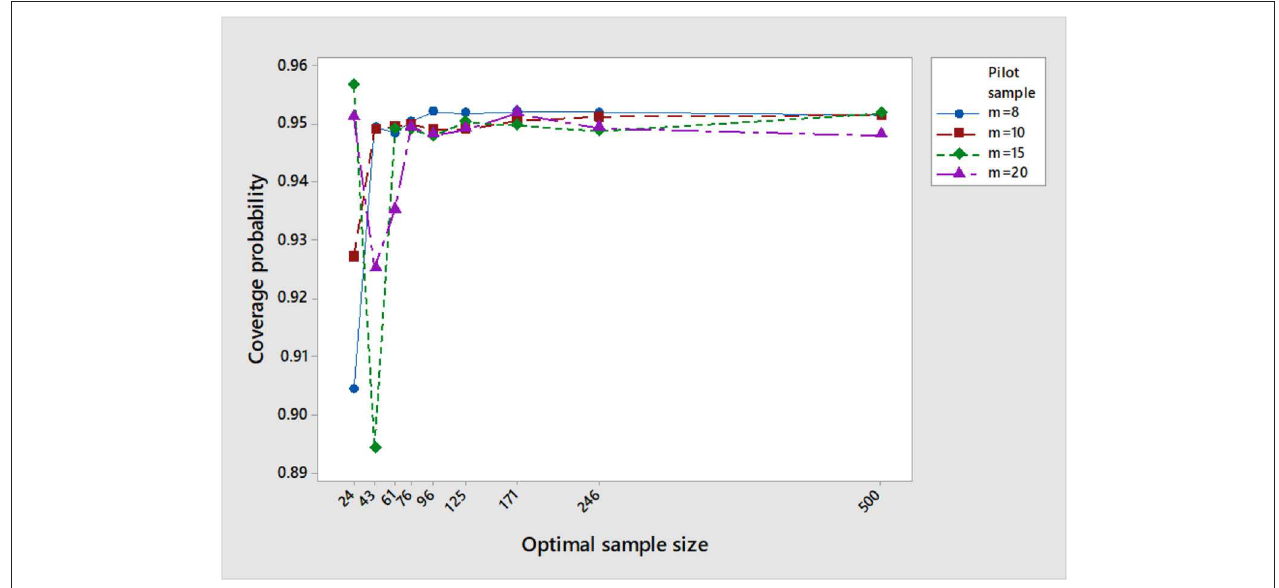
FIGURE 2 | The impact of increasing m on the coverage probability at µ